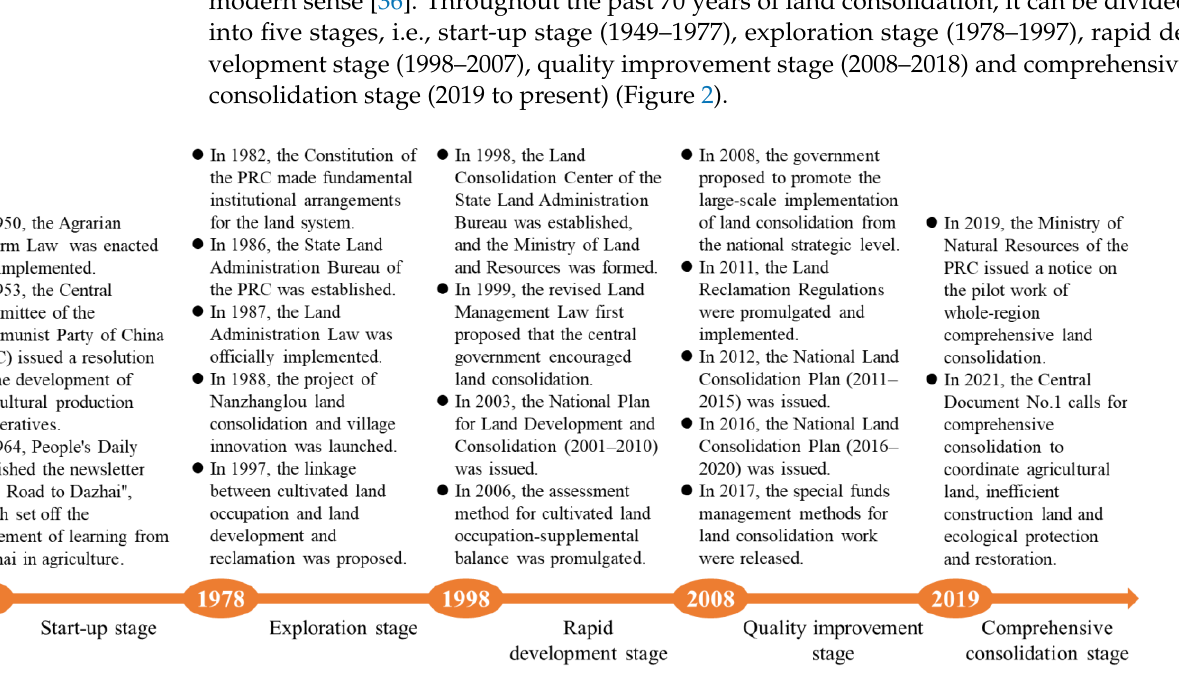
Figure 2. Historical stages of rural land consolidation in China since